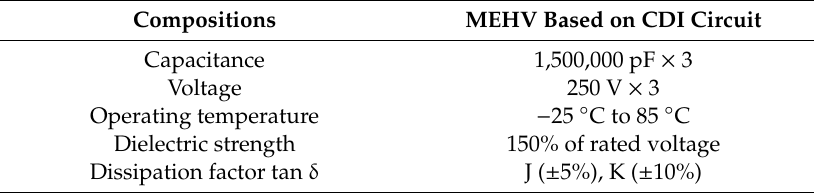
Table 3. MEHV circuit specifications.